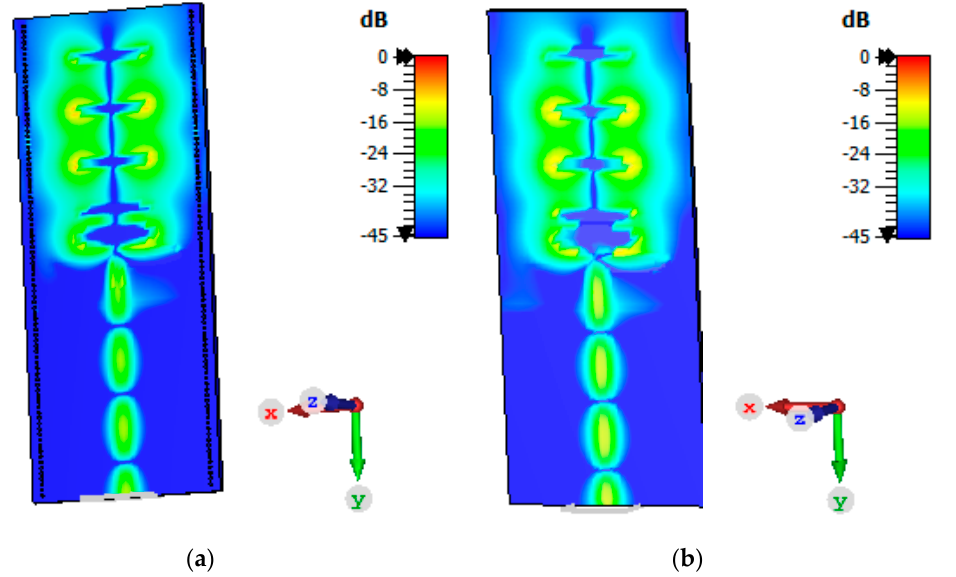
Figure 10. Snapshot photograph presenting the electric field distribution ( a ) with via-holes and ( b ) without via-holes.